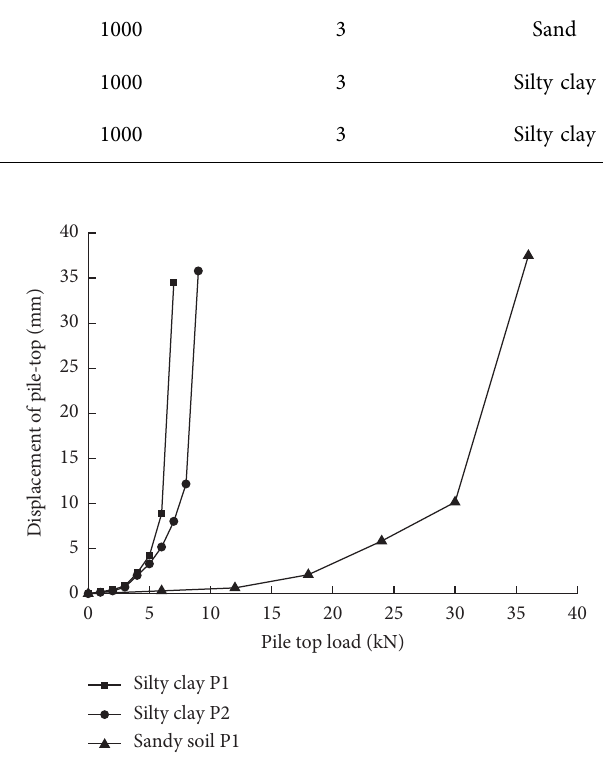
Figure 5: The tip displacement of pile in different soils along with load change.